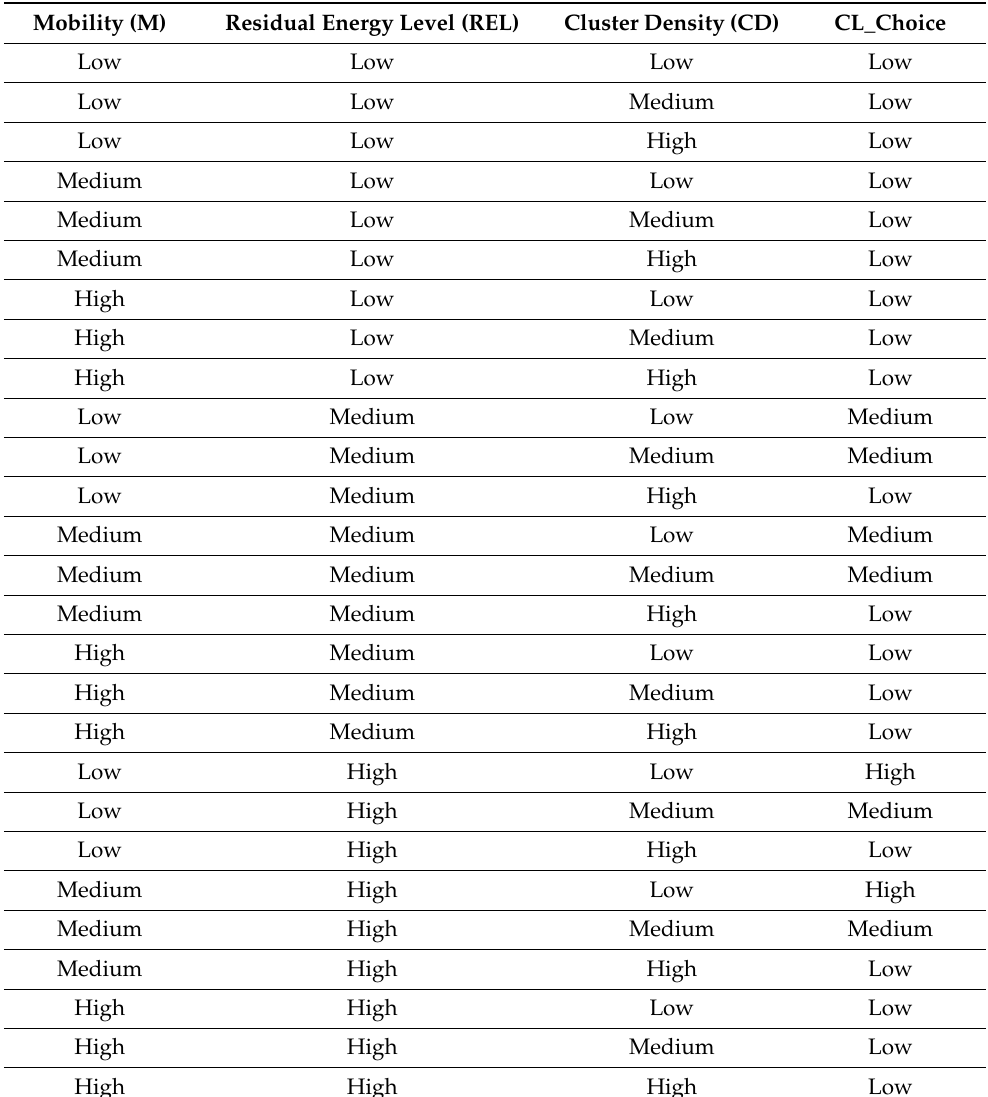
Table 1. Fuzzy “if-then“rules